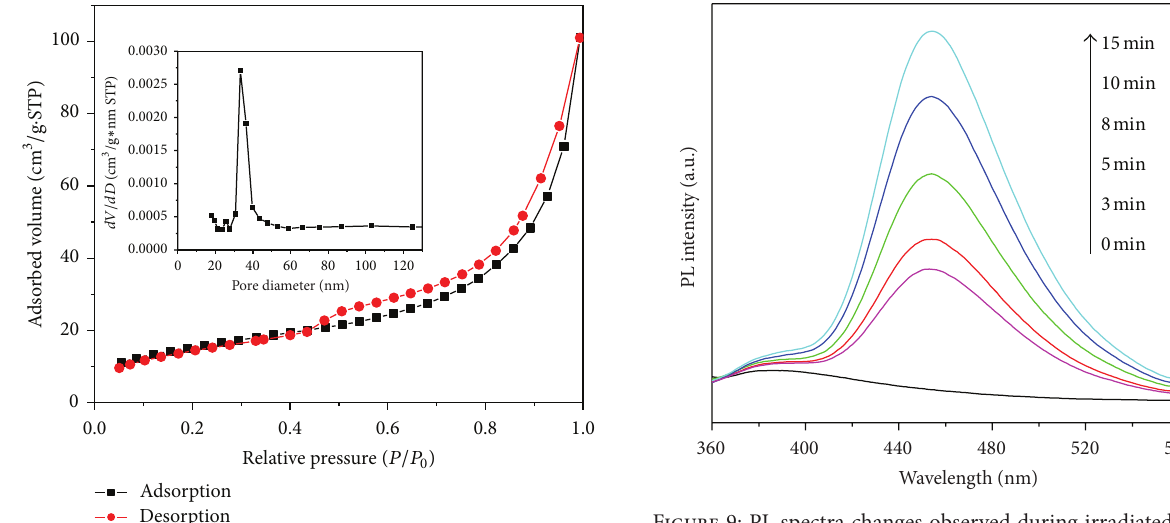
Figure 9: PL spectra changes observed during irradiated sunlight illumination of S1-10: 10wt% TiO 2 /CdS (10h) in coumarin solution (excitation at 332